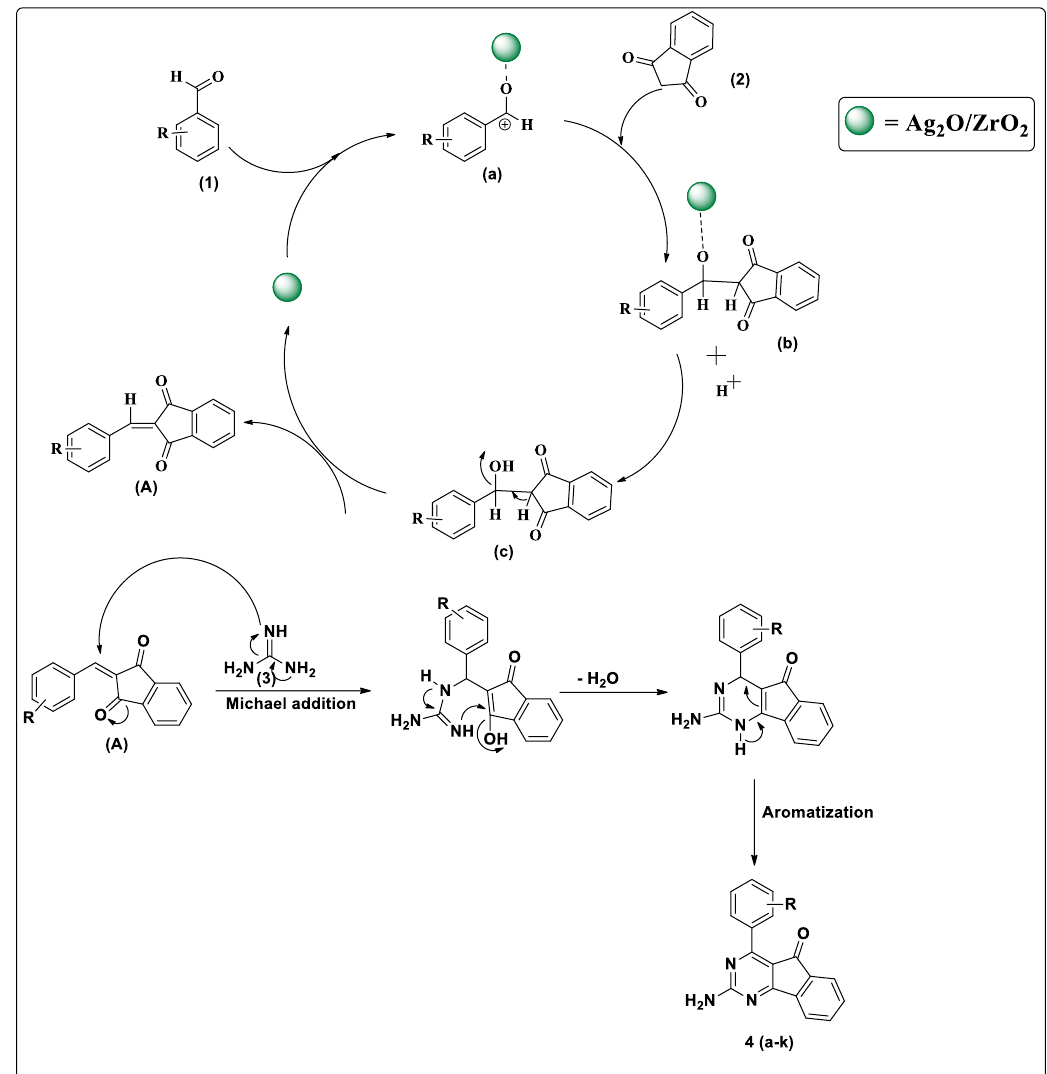
Table 5. A comparison table with various other catalysts for synthesizing pyrimidine